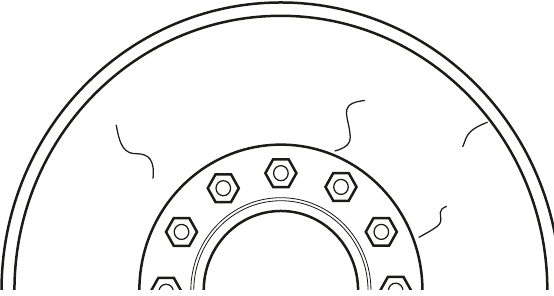
Figure 1: Cracks on brake disc